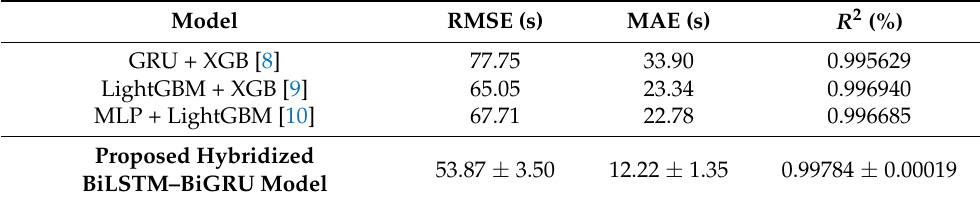
Table 7. Performance comparison of our proposed heterogeneous and reported ensemble approaches using the overall